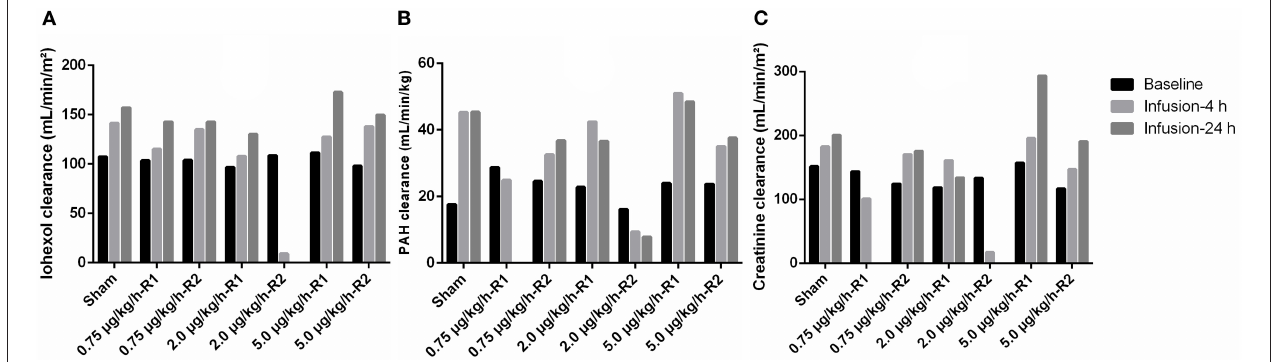
FIGURE 5 | Total body clearances of the renal markers iohexol [ A , 64.7 mg/kg body weight (BW)], para-aminohippuric acid (PAH, B , 10 mg/kg BW) and creatinine ( C , 40 mg/kg BW) at baseline, and at 4 (infusion-4h) and 24 (infusion-24h) hours after the start of a 36h continuous intravenous infusion of either 0.9% NaCl solution (6 ml/kg/h, sham, n = 1) or 0.9% NaCl solution (6 ml/kg/h) in combination with LPS (0.75; 2.0, and 5.0 µ g/kg/h, n = 2/group). R1 and R2 represent the two replicates per dose.